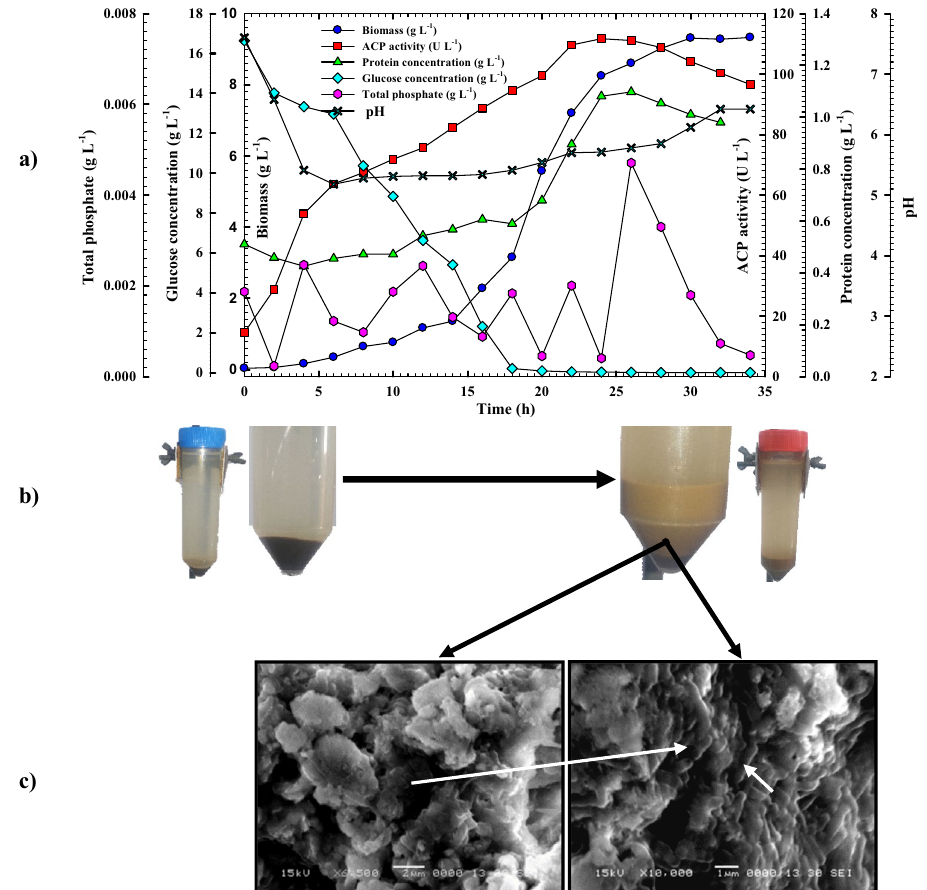
Figure 6. Monitoring of B. haynesii strain ACP1growth and acid phosphatase productivity in (a) a shake- flask scale cultivation condition, (b) rock phosphate leftover sample at the lag phase, and rock phosphate leftover sample at the end of the incubation time showing the solubilization process of rock phosphate, and (c) morphological characterization of RP surface illustrated the attached bacterial